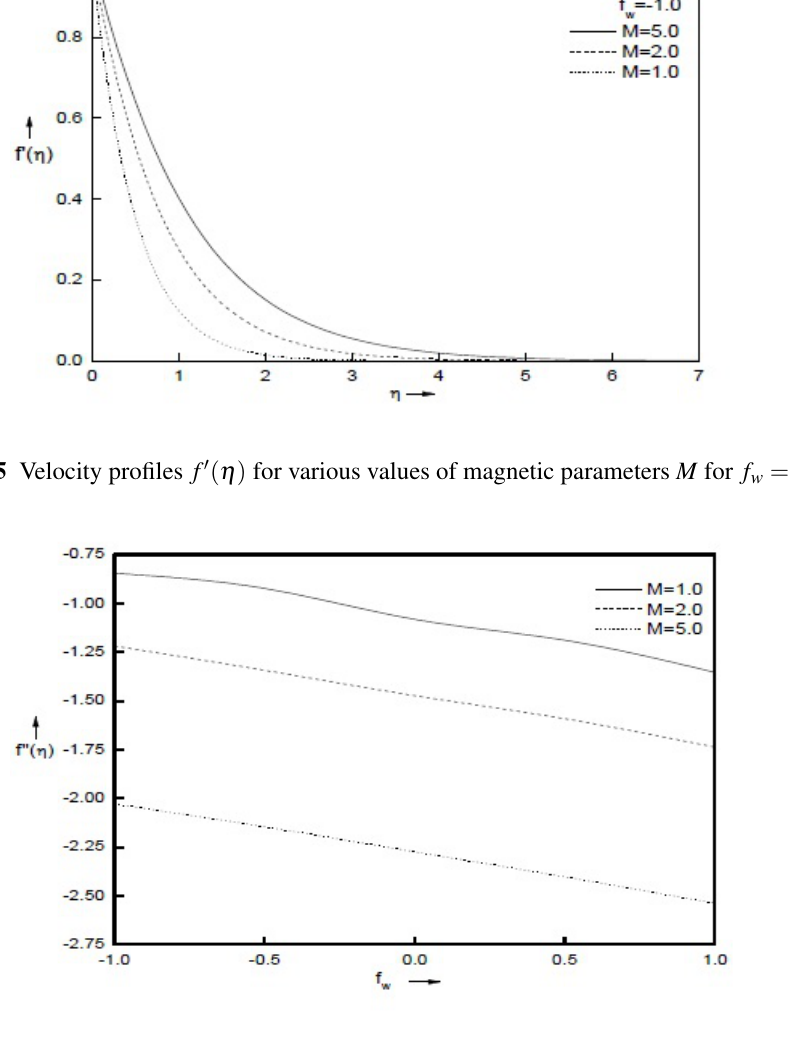
Fig. 6 Variation of f (cid:48)(cid:48) ( 0 ) with f w for various values of magnetic parameters M